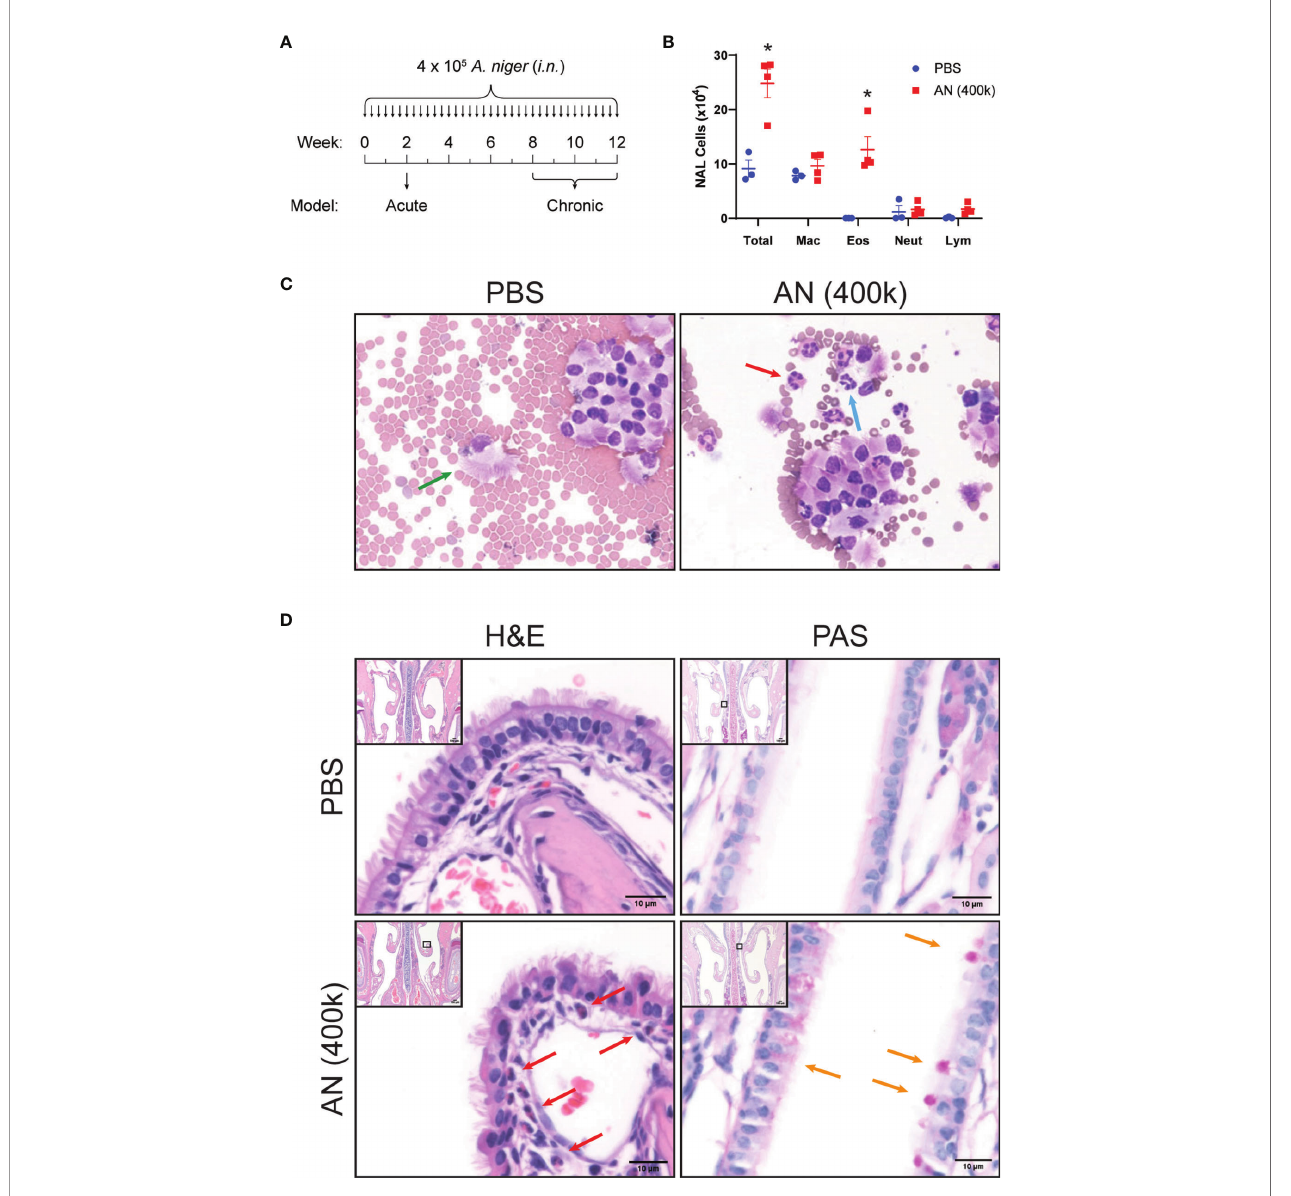
FIGURE 1 | Intranasal fungal challenge promotes eosinophilic sinus in fl ammation. (A) Experimental outline of acute and chronic models. Mice were i.n. challenged with 4 × 10 5 A. niger (AN) or PBS every other day for 2 weeks (acute) or 2 – 3 months (chronic) and assessed for in fl ammation. (B) Nasal airway lavage (NAL) in fl ammatory cells were quanti fi ed (C) from H&E-stained slides. (D) Representative H&E (left)- and PAS (right)-stained sinus sections from PBS- and AN-treated mice. Arrows indicate epithelial cells (green), eosinophils (red), neutrophils (blue), and mucus-stained goblet cells (orange). Results represent mean ± s.e.m. from two independent experiments; * p < 0.001, n ≥ 3 by two-way repeated measures